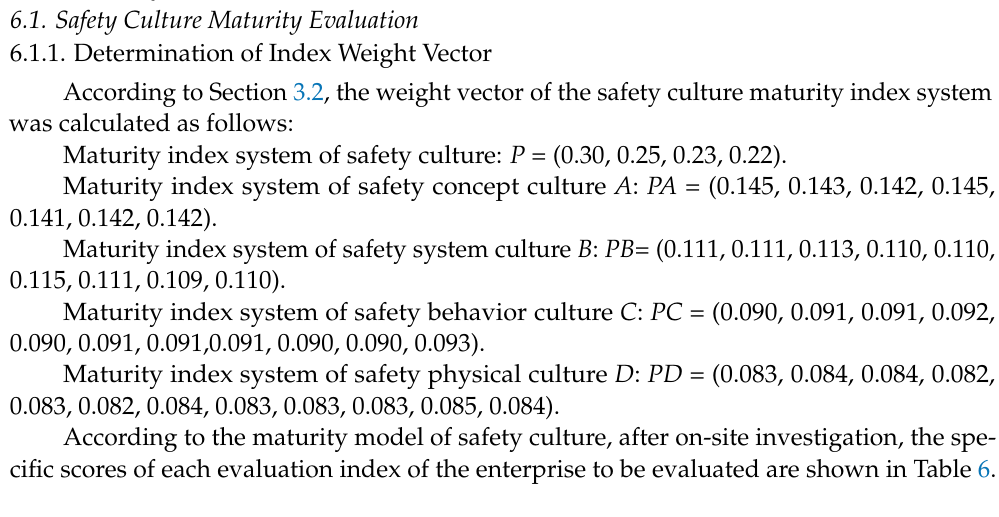
Table 6. The Corresponding Table of Each Indicator Set of The Enterprise to be Evaluated. Index Set Safety culture Y = {2.575, 3.328, 2.818, 3.085} Safety concept culture A Y A = {3, 3, 2, 3, 2, 3, 2} Safety system culture